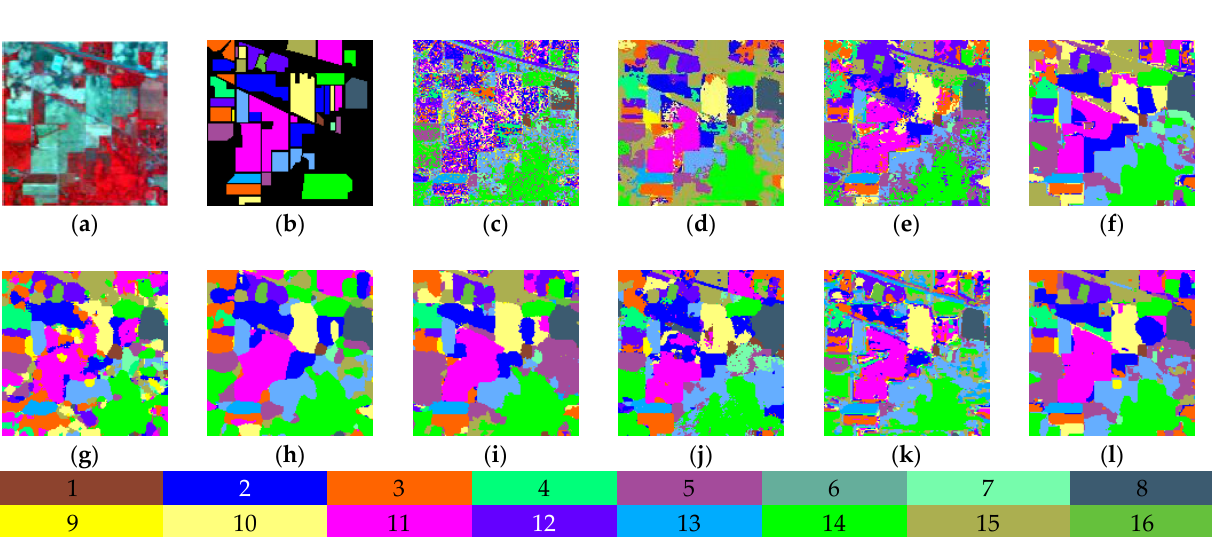
Figure 2. Indian Pines dataset. ( a ) False color composite image; ( b ) Ground truth image; ( c ) SVM; ( d ) LCMR; ( e ) RPNet; ( f ) MSTV; ( g ) GTR; ( h ) DBDA; ( i ) FDSI; ( j ) l 0 - l 1 HTV; ( k ) SpectralFormer; ( l ) Our method. Color illustrations of all classes are shown